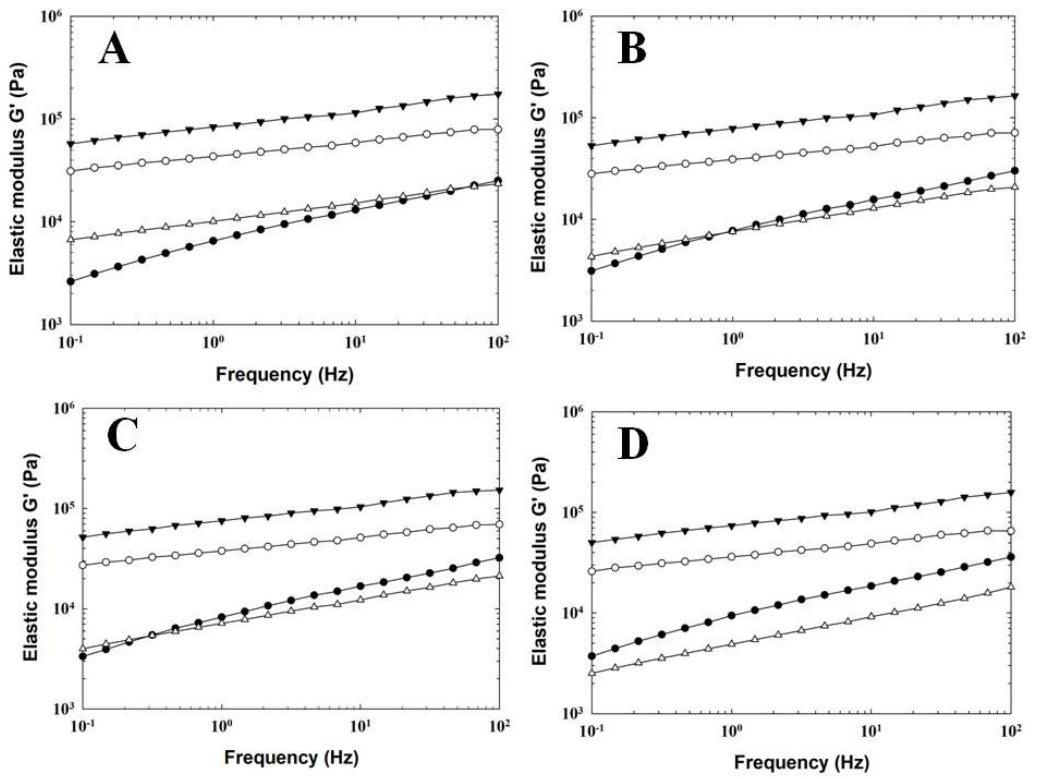
Figure 2. Development of elastic modulus G ′ values for processed cheese samples manufactured with different types of hydrocolloids (control sample—full circle; agar—open circle; κ -carrageenan—full triangle; gelatin—open triangle;) without emulsifying salts, a storage period of 60 days (at 6 ± 2 ◦ C). Processed cheese samples were sampled after 2 (part ( A )), 9 (part ( B )), 30 (part ( C )), and 60 (part ( D )) days of storage.